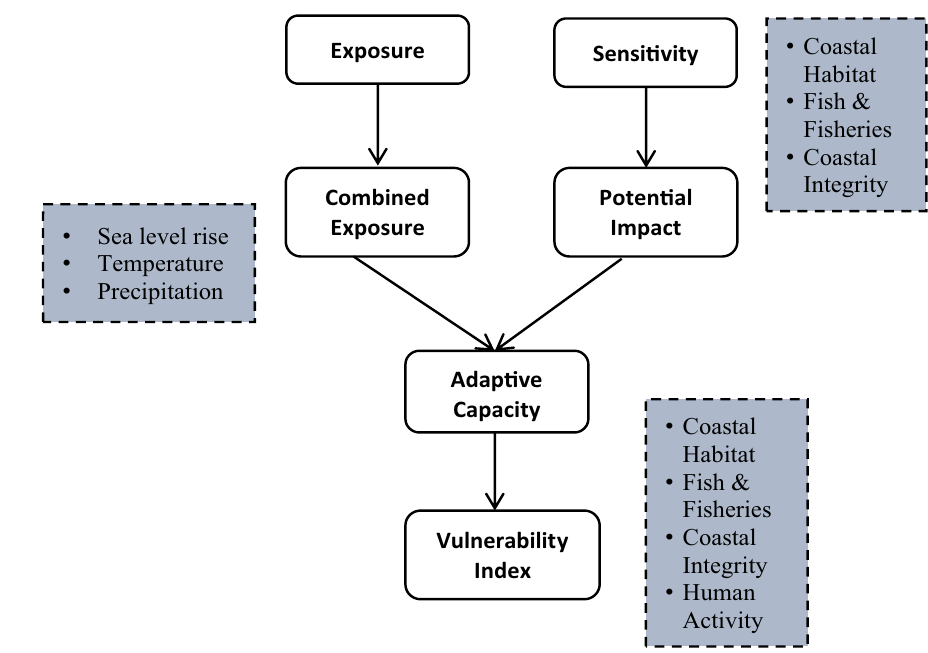
Fig. 2 Climate change vulner- ability assessment